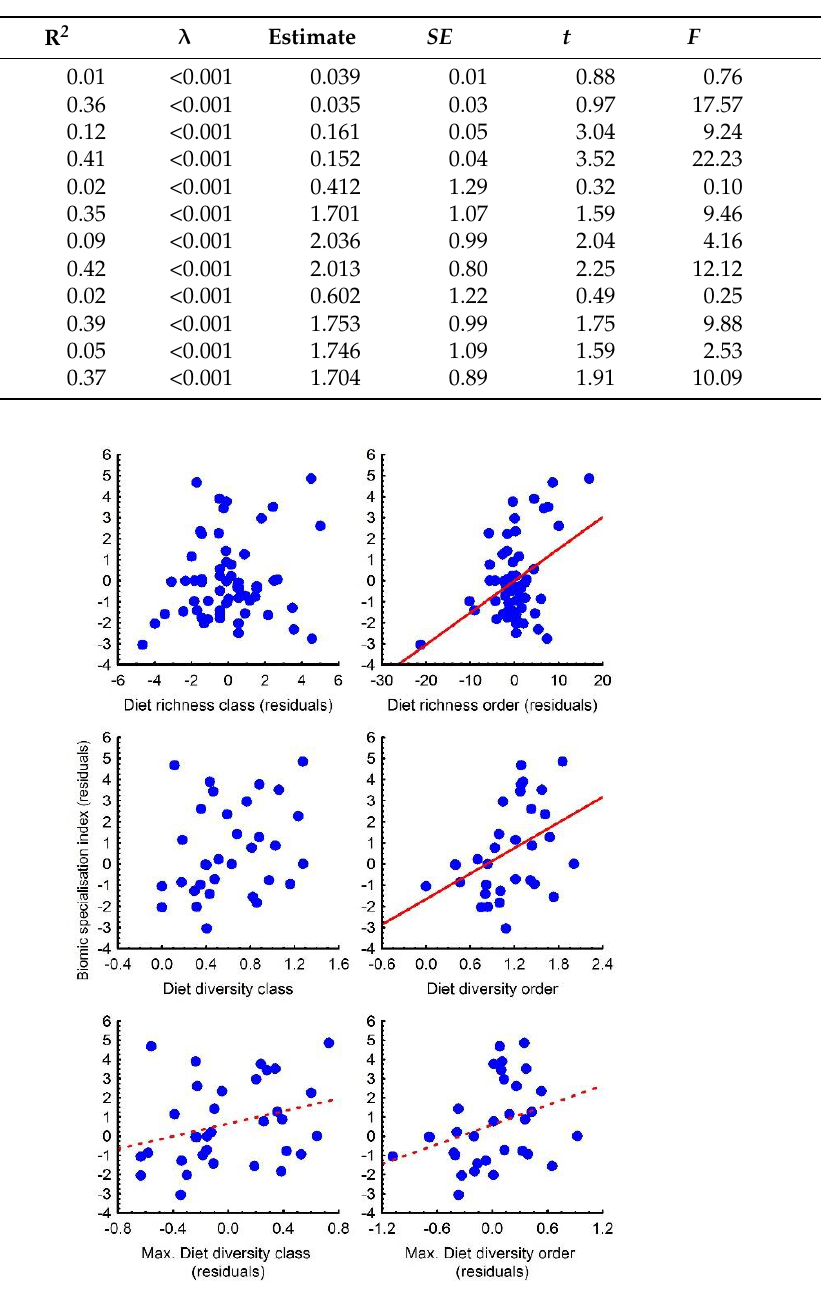
Table 2. Results of phylogenetic generalised least squares (PGLS) models for the relationship be- tween biomic specialisation index (BSI) and detrended diet richness (dDR), diet diversity (DD) and detrended maximum diet diversity (dMDD) at class (c) and order (o) taxonomic ranks of Falconidae species. Data on raw models and after the inclusion of range size of the distribution area as a covari- ate are shown. R 2 and F values correspond to the whole model and estimate, t and p values to the independent variable. The effect of range size was significant (all p < 0.001) in all models.